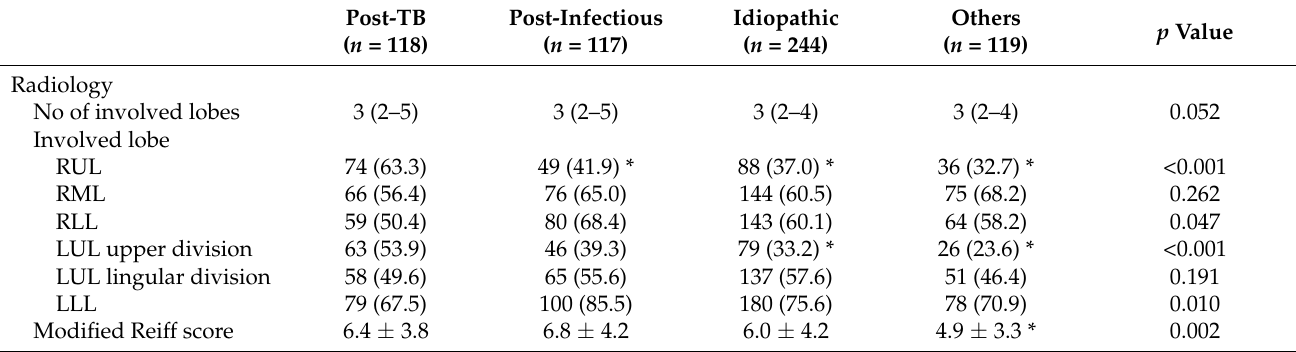
Table 2. Radiologic, pulmonary function, microbiologic, and laboratory test results in patients with bronchiectasis according to their